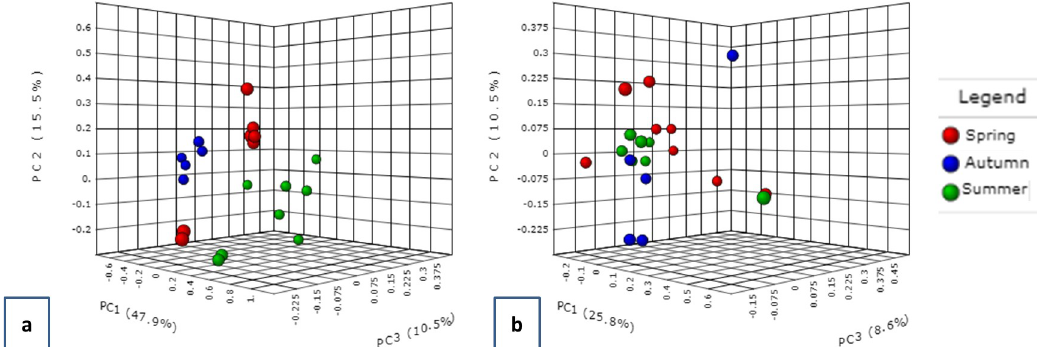
Fig 8. Beta diversity clustering based on PCoA on the Bray Curtis distances of (a) bacterial and (b) fungal genus distributed during the three seasons in Kuwait. The colours represent the three seasons blue (autumn); red (summer); green (spring).